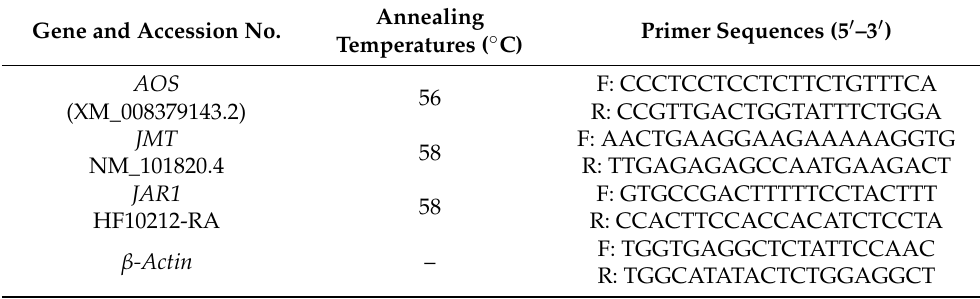
Table 2. Primer sequences and annealing temperatures of allene oxide synthase (AOS), jasmonic acid carboxyl methyltransferase (JMT), and jasmonate-resistant 1 (JAR) in apple roots. Gene and Accession